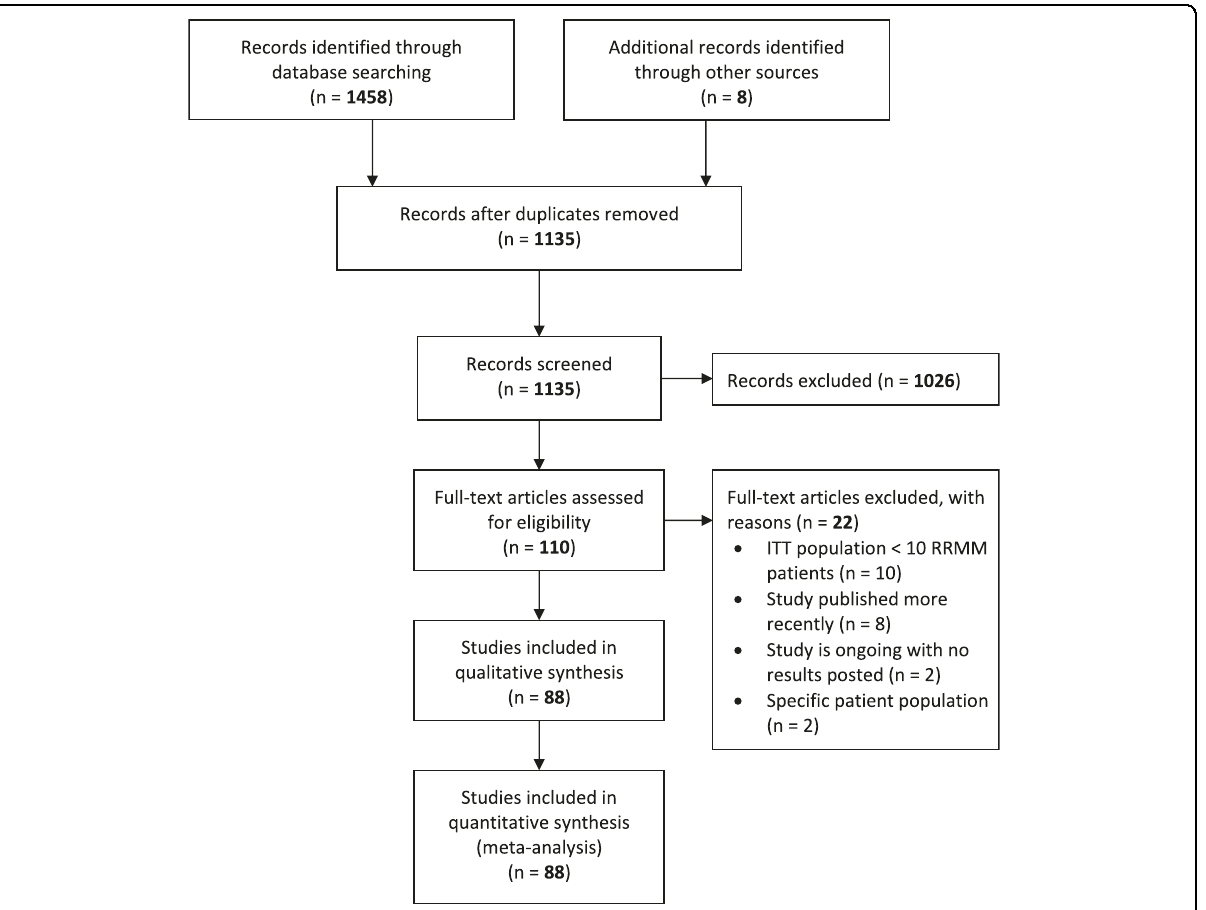
Fig. 1 PRISMA fl ow diagram of the study selection process. ITT intention-to-treat, RRMM relapsed/refractory multiple